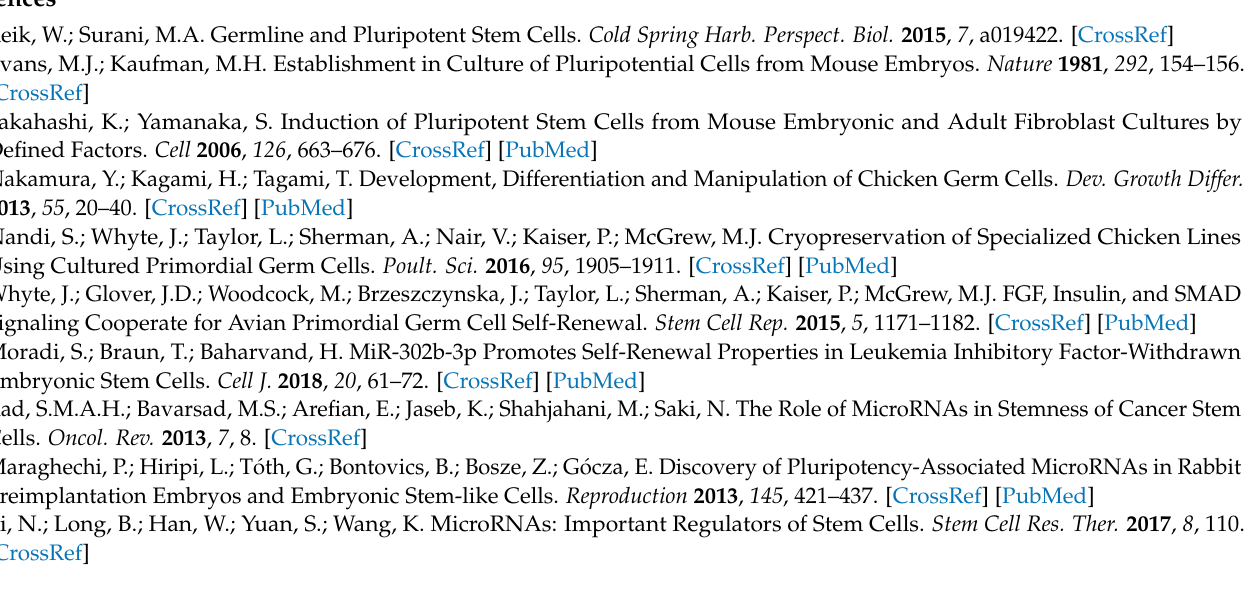
Figure S4: Immunostaining of 5P inhibited M1 PGCs on Day